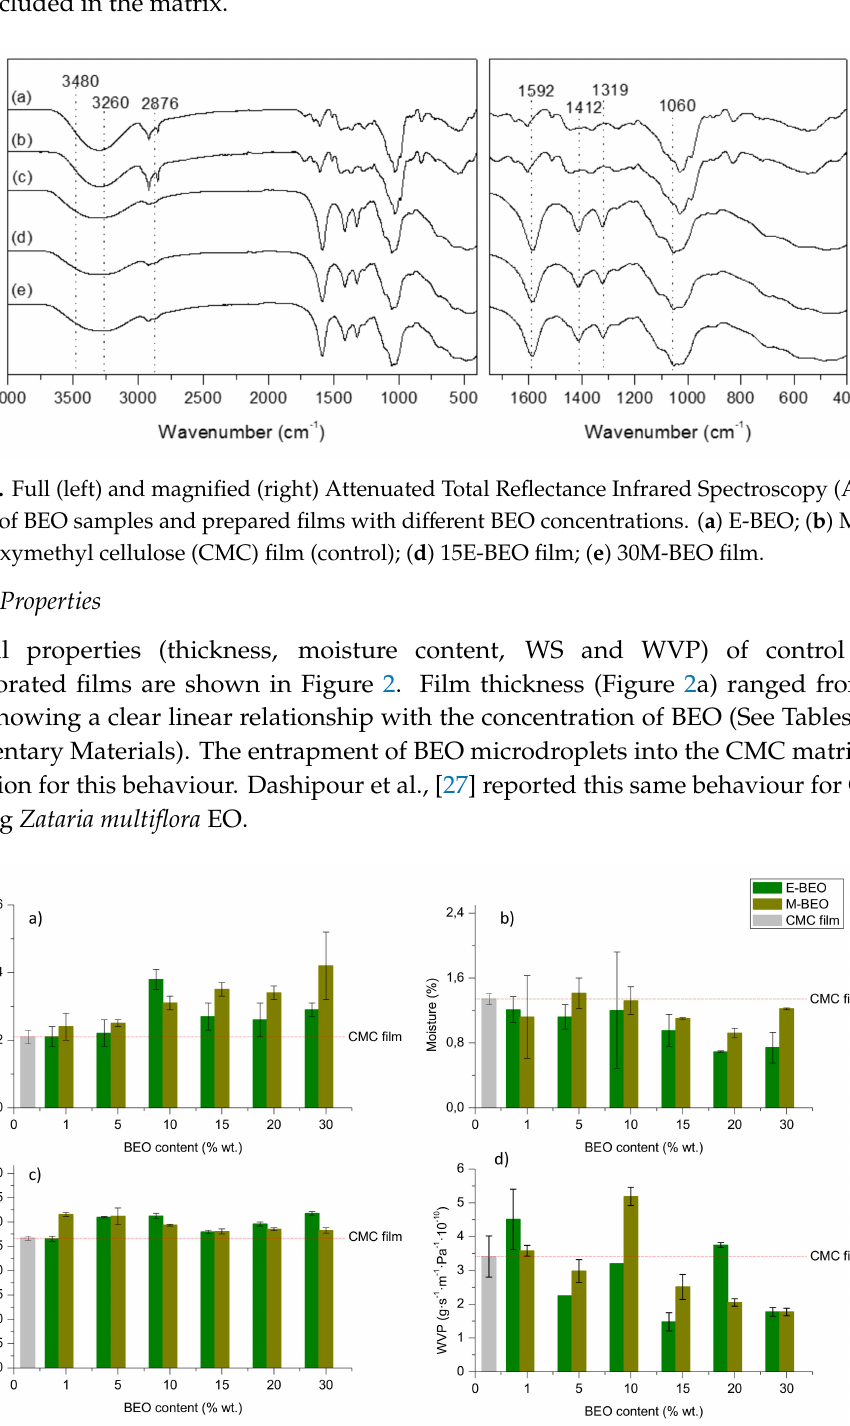
Figure 2. Physical properties of CMC films formulated with di ff erent concentrations of BEO: a ) thickness (mm); b ) moisture content (% wt.); c ) solubility in water (% wt.) and d ) water vapor permeability (WVP, g · s − 1 · m − 1 · Pa − 1 · 10 − 10